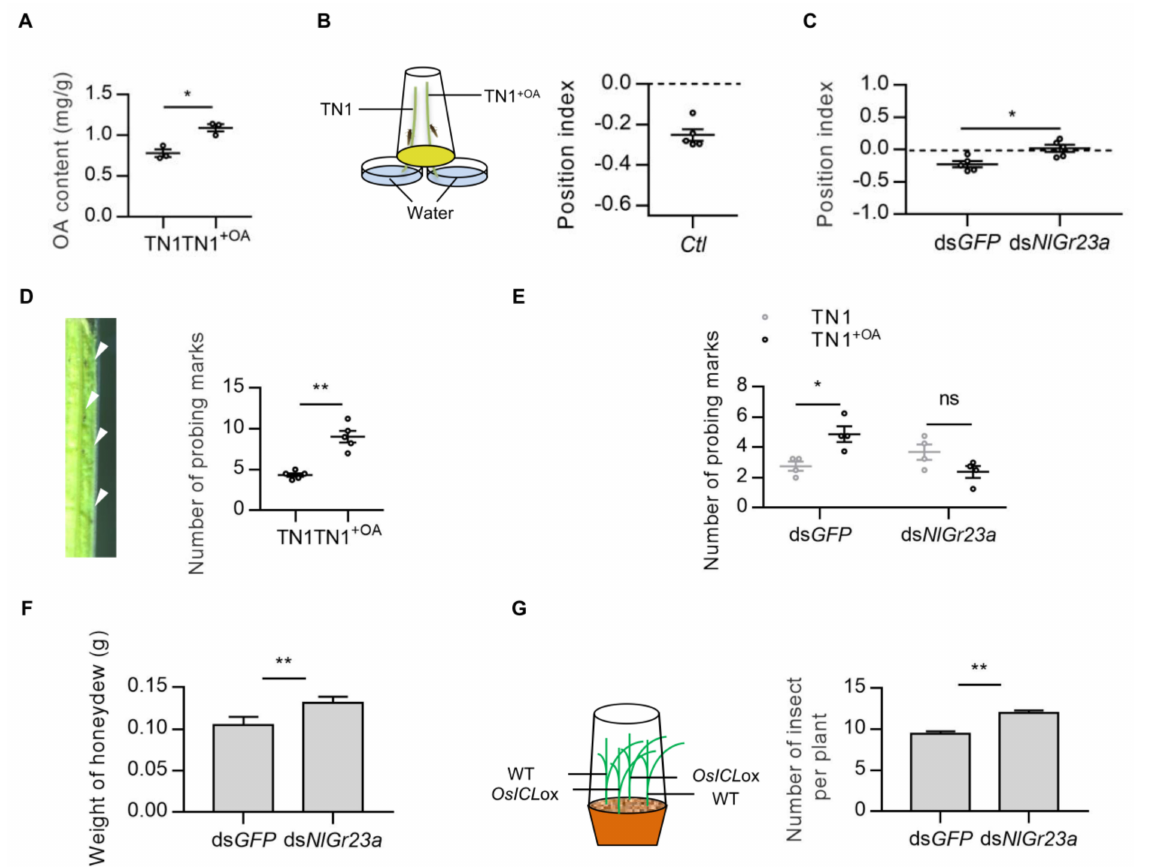
Figure 2. NlGr23a mediated the antifeedant activity of oxalic acid in rice plants. ( A ) OA content before and after immersion treatment in TN1. The TN1 +OA represents TN1 treated with 0.2% OA solution. Bars represent means ± SEM. Mann–Whitney non-parametric test; * p < 0.05 ( n = 3). ( B ) Left: Schematic representation of the experimental apparatus used for dual-choice test with rice plants. Right: Collective data ( n = 5) of the position index (PI) of Ctl in response to TN1 +OA . Bars represent means ± SEM. ( C ) PI values for NlGr23a dsRNA-treated and GFP dsRNA-treated BPHs in response to TN1 +OA in dual choice assays. Bars represent means ± SEM. Mann–Whitney non-parametric test; * p < 0.05 ( n = 5). ( D ) Left: Probing marks left on the surface of a rice stem. Right: Collective data ( n = 5) of the number of probing marks on the surface of TN1 +OA or TN1 after BPH infestation. Bars represent means ± SEM. Mann–Whitney non-parametric test; ** p < 0.01. ( E ) Collective data ( n = 4) of the number of probing marks on the surface of TN1 +OA or TN1 made by BPHs treated with NlGr23a dsRNA or GFP dsRNA. Bars represent means ± SEM. Mann–Whitney non-parametric test; ns means no statistical difference ( p > 0.05); * p < 0.05. ( F ) Weight of honeydew secreted by three female BPH adults after 48 h feeding on OsICL -overexpressing transgenic plants ( OsICL ox). Bars represent means ± SEM. Mann–Whitney non-parametric test; ** p < 0.01 ( n = 12). ( G ) Left: Schematic representation of the experimental apparatus used for host choice test. Right: Number of female BPH adults per OsICL ox plant at 48 h post-infestation. Bars represent means ± SEM. Mann–Whitney non-parametric test; ** p < 0.01 ( n =